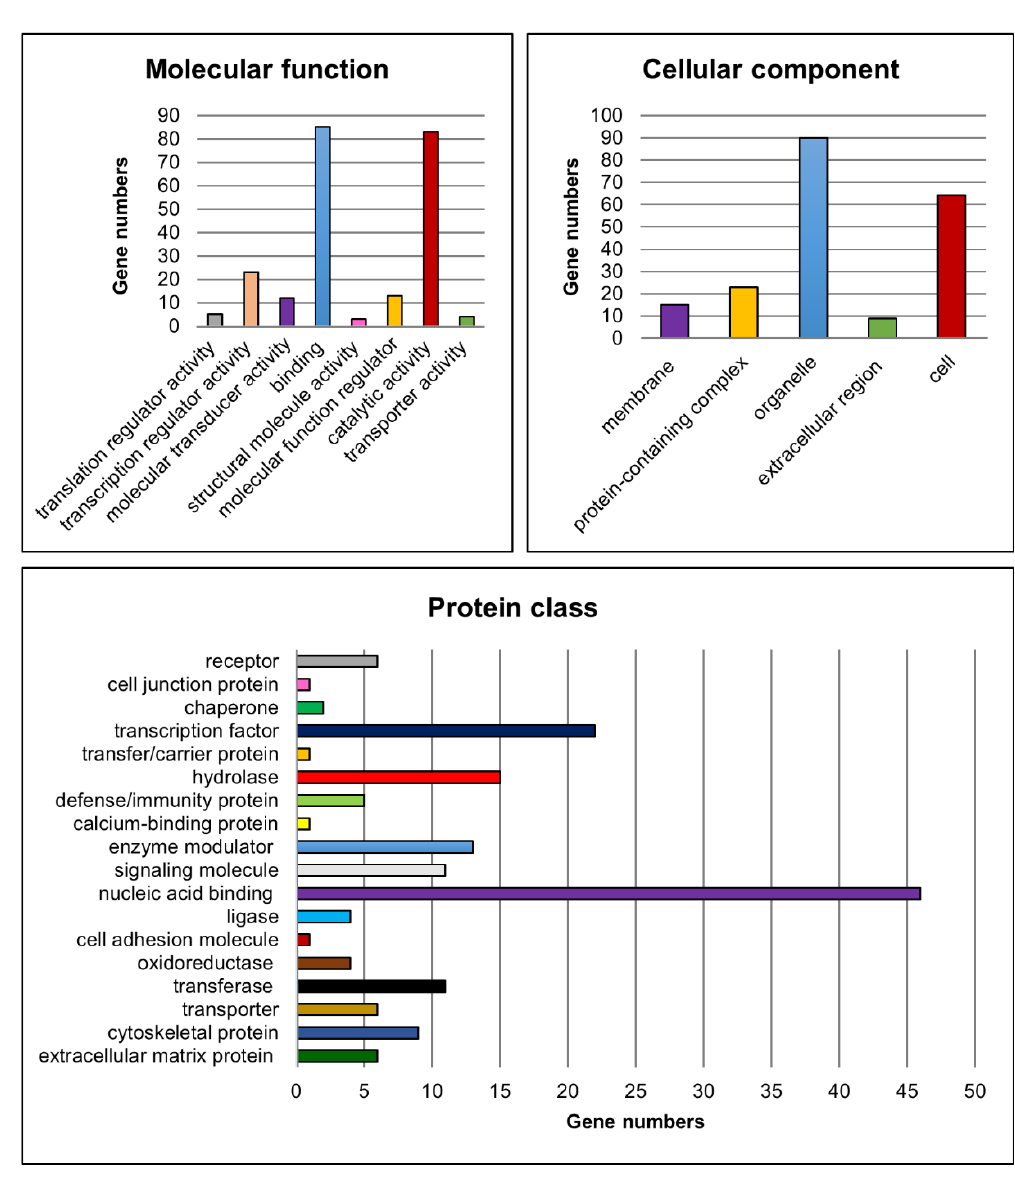
Figure 7. Functional classification of potential candidate genes. Charts showing numbers of potential candidate genes related to the corresponding gene ontology categories for the terms molecular function, cellular component and protein